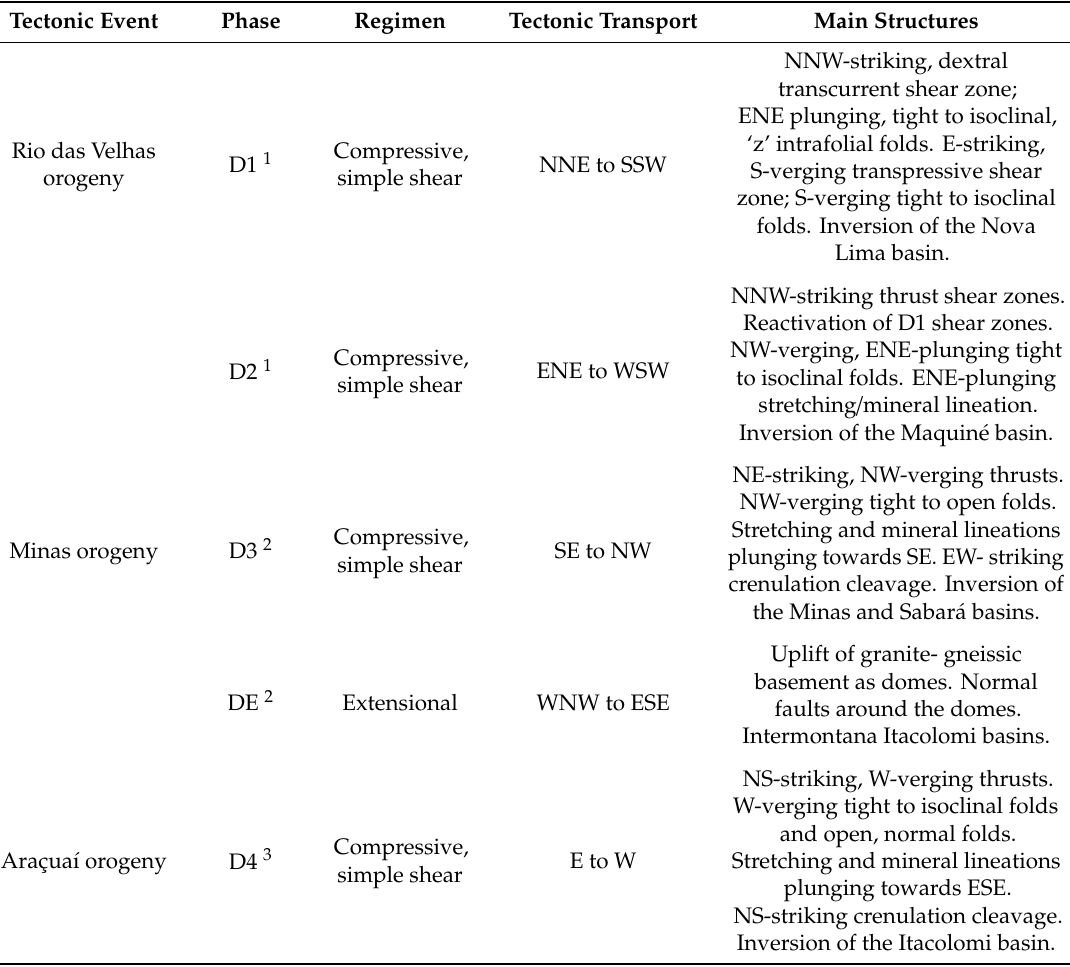
Table 1. Synthesis of structural evolution of the Archean Rio das Velhas greenstone belt and Proterozoic cover sequences in the Quadril á tero Ferr í fero